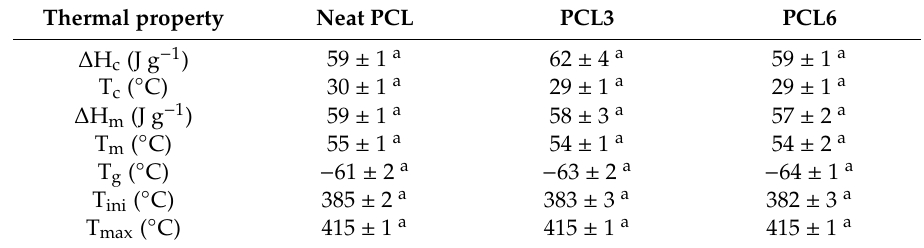
Table 2. Thermal properties of neat PCL and PCL / ASE composite films obtained by DSC and TGA. Thermal property Neat PCL PCL3 PCL6 − 1 ) 59 ± 1 ∆ H c (J g